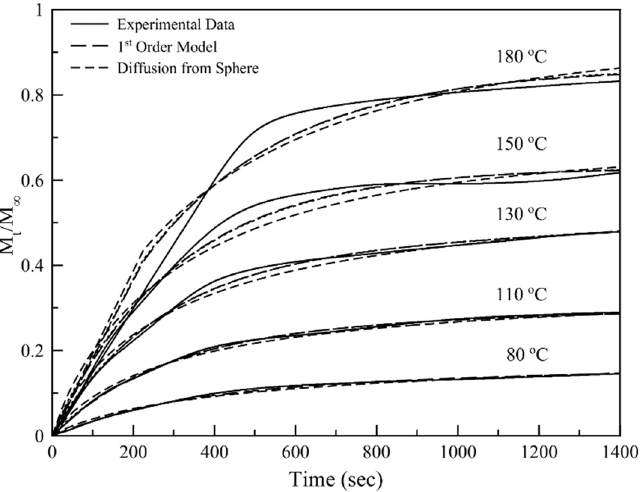
Figure 10. Normalized isothermal TGA data obtained for different temperatures, fitted by a first- order and a diffusion-based mathematical model. Table 6. Parameters estimated for each desorption data, fitted with a first-order and a diffusion- based model. 1st Order